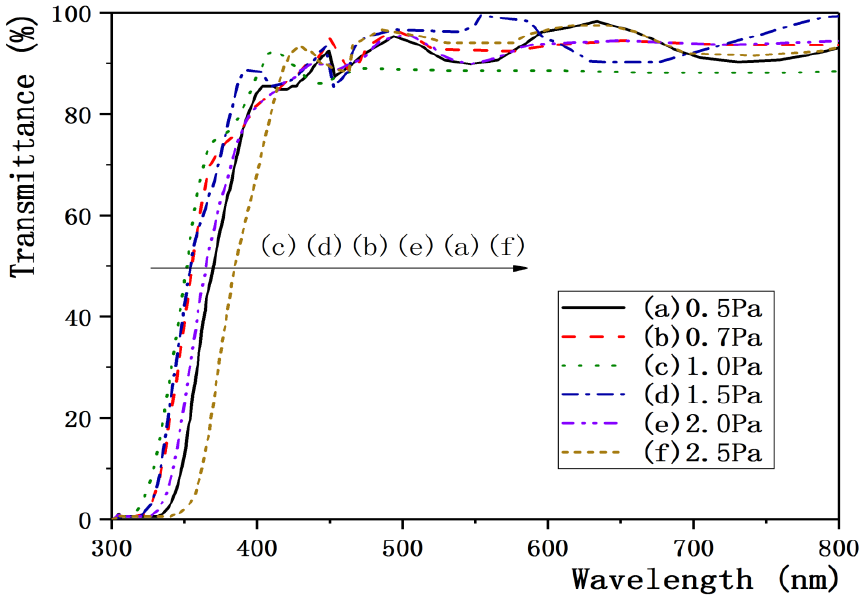
Figure 8. Transmission spectra of ZnO:Ga films prepared at different sputtering pressures [75]. Table 4. The performances of ZnO:Ga films produced at different sputtering pressures [75]. Sputtering Pressure (Pa) 0.5